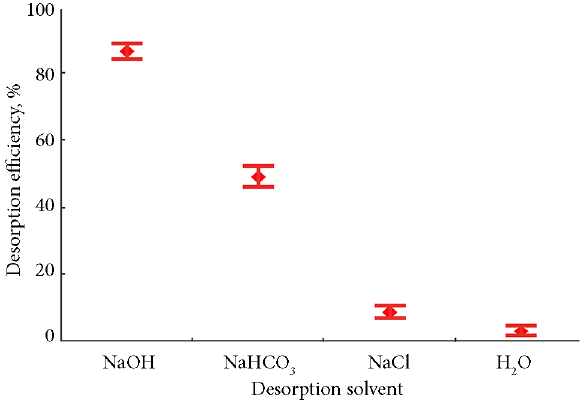
Figure 11. Effect of desorption solvent types on the As(V) desorption efficiencies